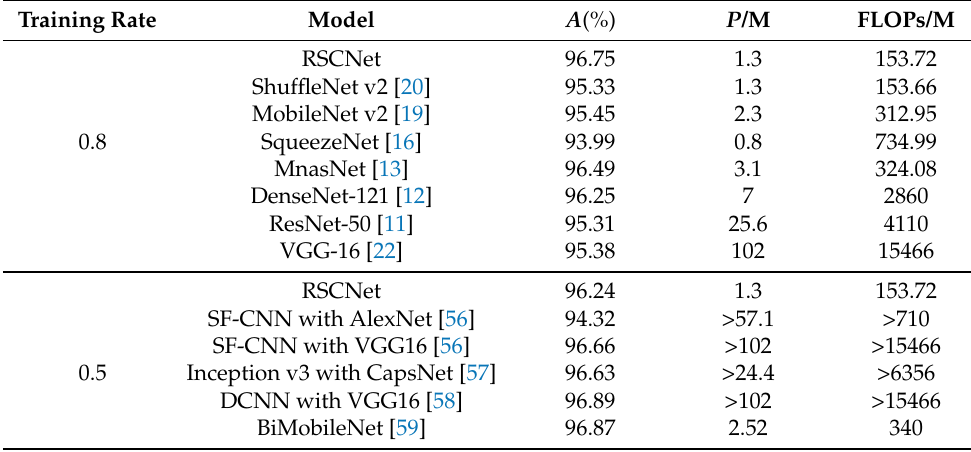
Table 7. Results of various models on AID